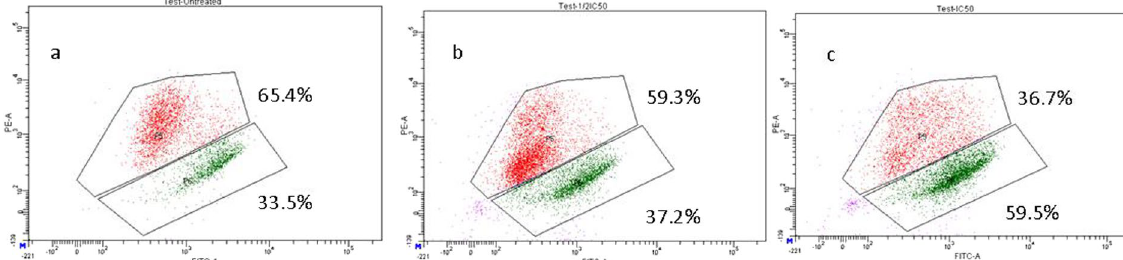
Figure 10. Mitochondrial depolarisation initiated by CPT-CEF. As analysed with JC-1 dye and flow cytometry, CPT-CEF treatments of A549 cells with concentrations of ½ IC 50 (panel b), IC 50 (panel c), or untreated (panel a) for 48 h are shown.